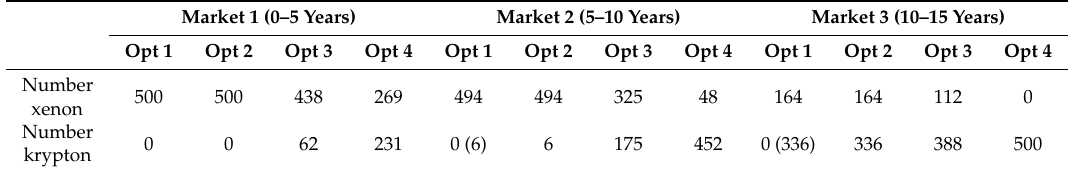
Table 2. Number of chosen xenon-based EP and krypton-based EP after 500 runs of the surplus value